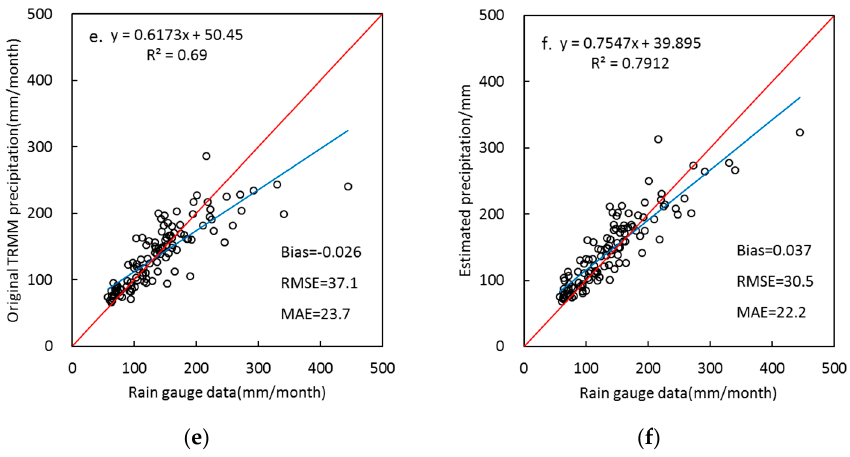
Figure 13. Comparison of monthly precipitation measured by RGS with ( a ) original monthly TRMM data; ( b ) downscaled monthly data; ( c ) original monthly TRMM data in the dry season; ( d ) downscaled monthly data in the dry season; ( e ) original monthly TRMM data in the wet season; and ( f ) downscaled monthly data in the wet season. The red line indicates a 1:1 correspondence and the blue line gives the linear regression best fit.